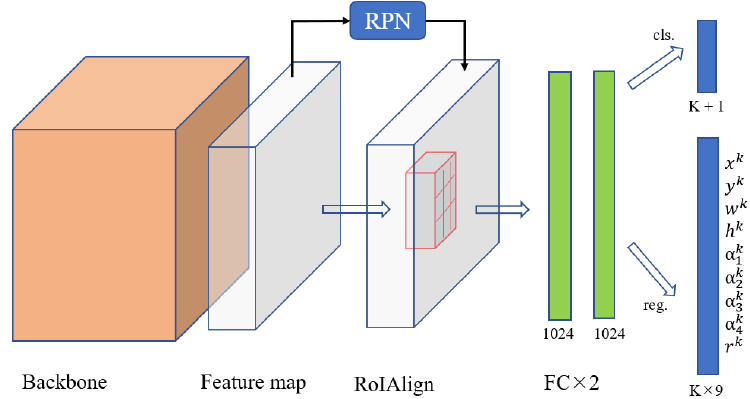
Figure 16. The network architecture of Gliding Vertex.